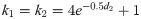
Dependence of relative change ratios on the green loop length: (A) mean expression and (B) noise intensity. Here, parameter values are set as d1 = 1500, λ21 = λ32 = λ34 = λ41 = 0.3, μ = 10, δ = 1, r = 0.15, and k1 = k2 = 0.5 for alternating loops but k1=k2=4e−0.5d2+1 with d2 ∈ (40,10000) for nested loops.